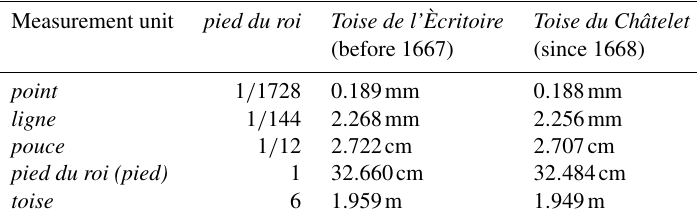
Table 2. Measurement systems used in 17th-century France (Blamont, 2001).